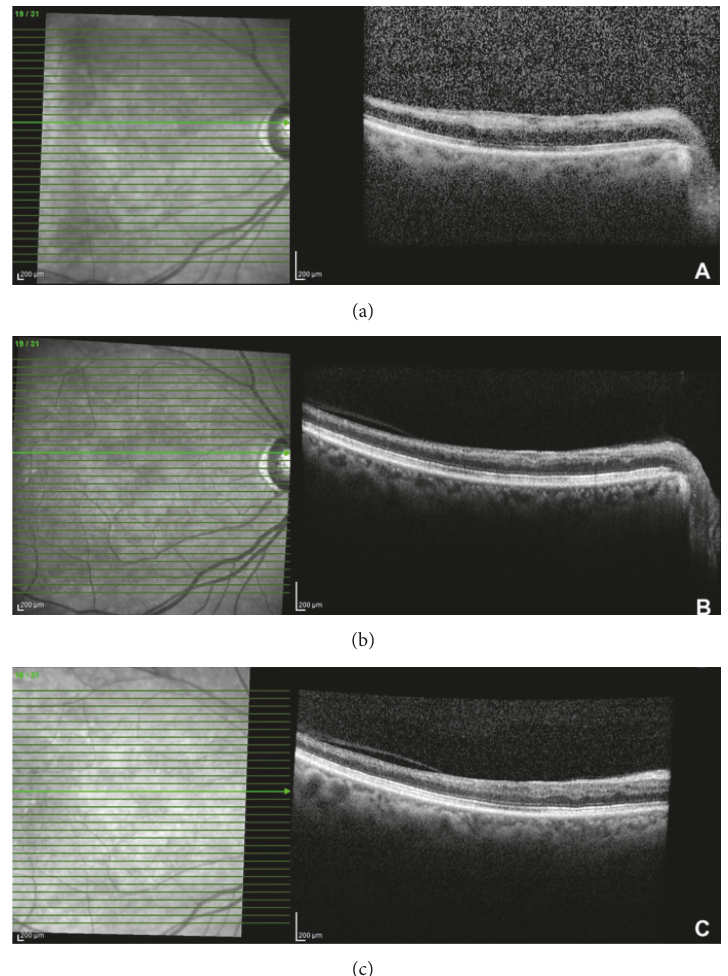
Figure 3: Optical coherence tomography showing inner retinal thickening and hyperreflectivity at the time of acute vision loss, a year and a half following her initial presentation where BCVA was CF (a). Optical coherence tomography imaging showing thinning and atrophy of the inner retina at six months (b) and one year after her acute vision loss secondary to BRAO